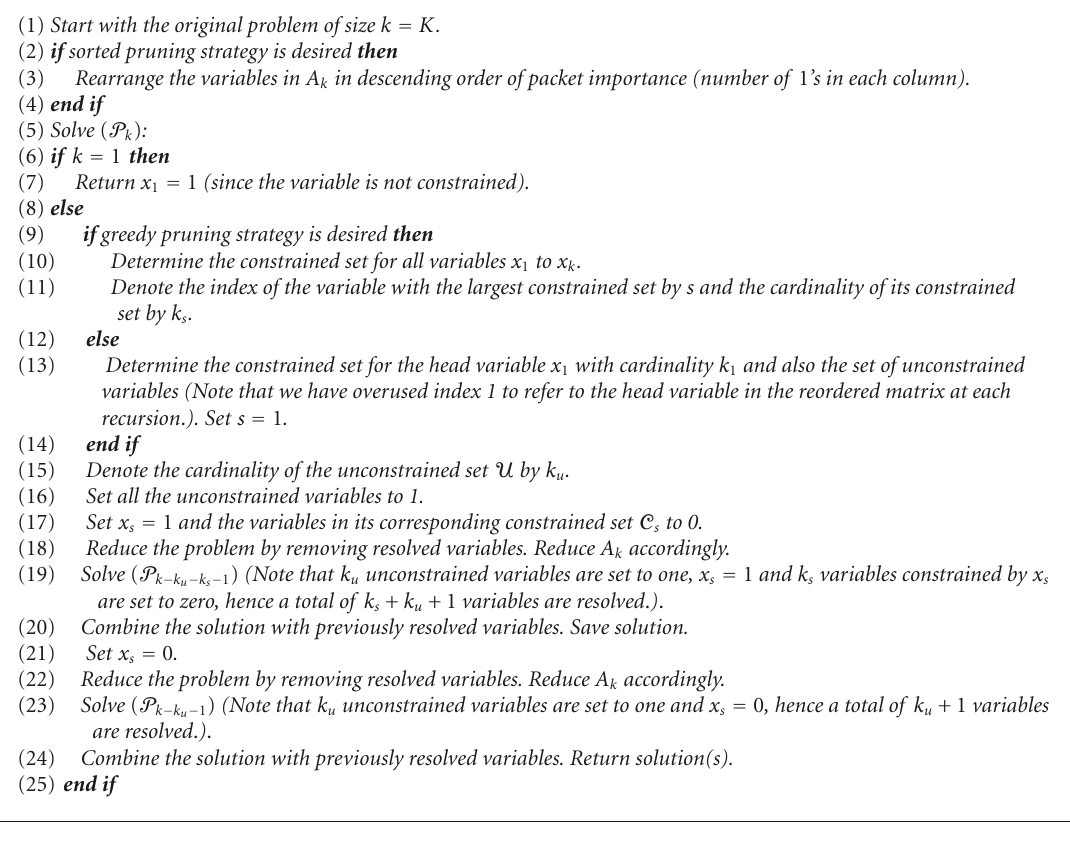
Algorithm 1: Recursive search for the optimal solution(s) of